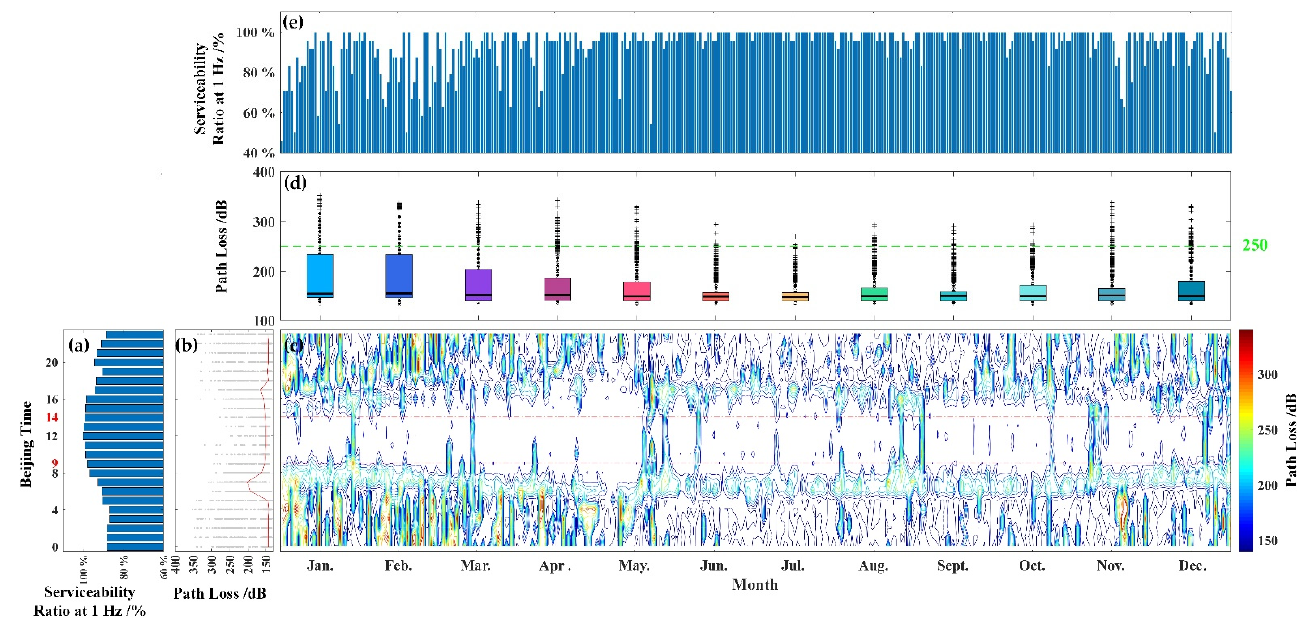
Figure 7. Propagation effects under the evaporation duct channel at the analyzed position (23.4° N, 120.0° E) for a 300 km range during 2020: ( a ) serviceability ratio at 1 Hz at different times of the day; ( b ) path loss distribution at different times of the day; ( c ) path loss spatial distribution of transmission link in the Taiwan Strait; ( d ) statistical results of path loss in different months; ( e ) serviceability ratio at 1 Hz in different months.